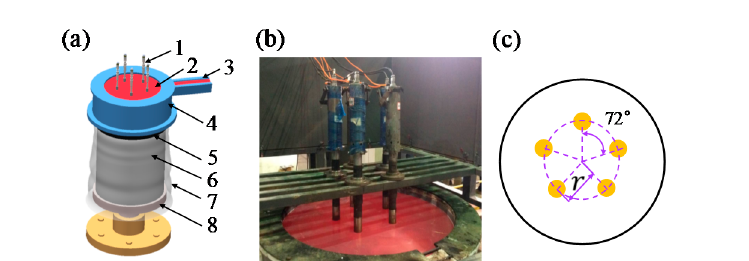
Figure 1. ( a ) Schematic illustration of the ultrasound-assisted direct-chill casting system for manufacturing large-scale Al alloy ingots, including 1. ultrasonic generators, 2. molten aluminum, 3. launder, 4. hot-top, 5. crystallizer, 6. ingot, 7. cooling water, 8. pulling device; ( b ) the industry-level casting apparatus for large-scale Al alloy casting. The five ultrasonic generators were symmetrically placed in ( c ), the value of radius ( r ) was 300 mm.